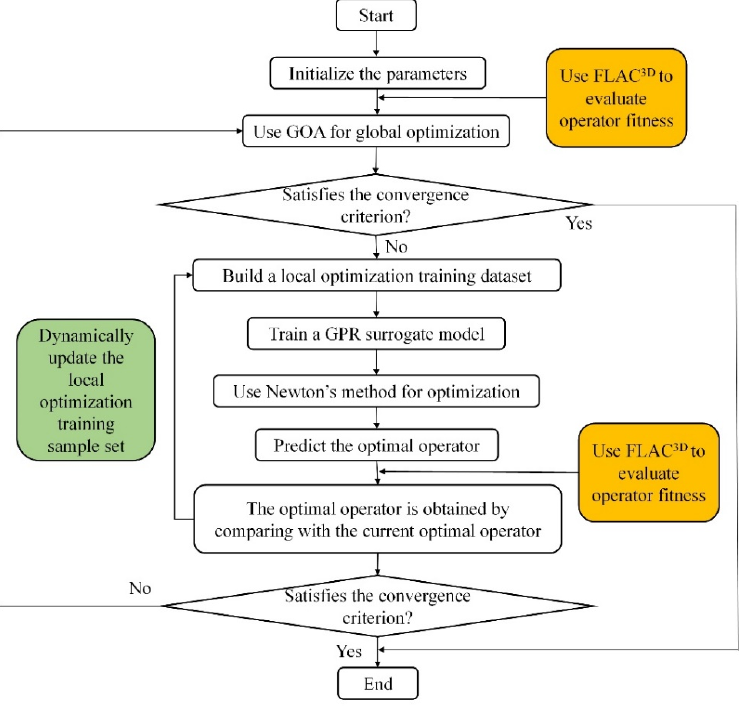
Figure 8. Flowchart of the GOA ‐ GPR ‐ FLAC 3D method.